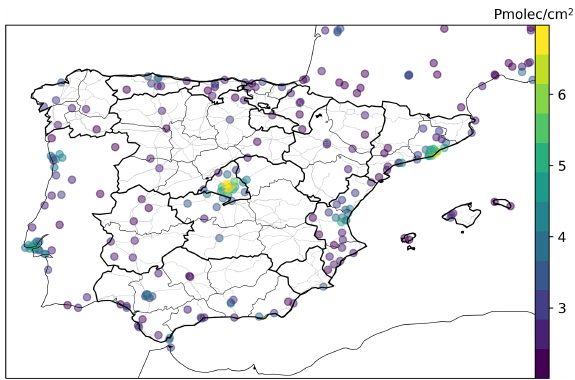
Figure G7. Mean TrC-NO 2 coincident with the 10% largest residuals of the daily scale TrC-NO 2 versus surface NO 2 linear regression, these high residuals correspond to situations where strong TrC-NO 2 were measured by TROPOMI, while comparatively lower NO 2 mixing ratios were measured by surface background stations (see text in Sect. 3.3). Black and grey lines correspond to administrative borders and Spanish major roads, respectively (sources: see Sect.